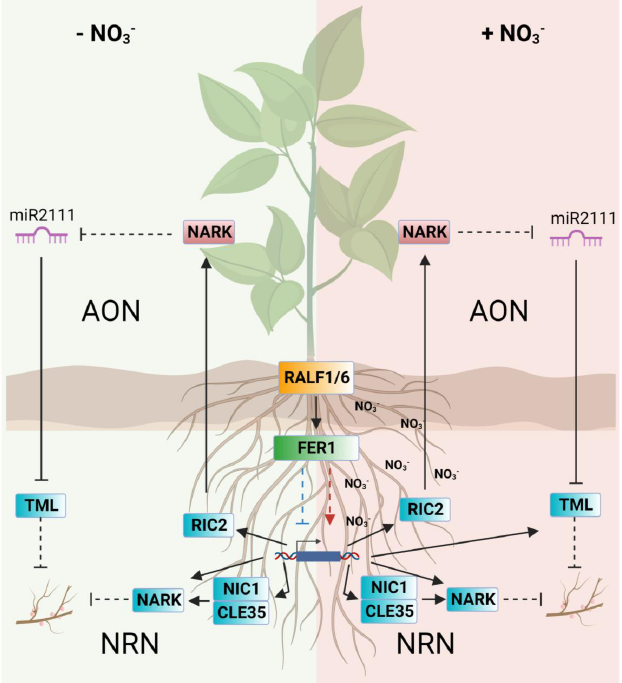
Figure 8. Proposed model for the regulation of the number of nodules in common bean by the PvRALF1/6-PvFER1 complex as a function of nitrate levels. In the absence of nitrate (left panel), RALF1 and RALF6 (orange box), and probably other RALFs, are perceived by FER1 (green box) and mediate the downregulation of the AON and NRN pathways, inducing the formation of more nod- ules. When nitrate is present (right panel), the RALF peptides are recognized by FER1 and mediate the upregulation of the AON and NRN pathways, leading to an inhibition of additional nodule formation. Solid lines indicate direct and dotted lines indicates indirect interaction. The arrowheads represent activation, and line endings indicate a repression. NO 2 − , nitrate; RALF1/6, RAPID ALKA- LINIZATION FACTOR 1/6; FER1, FERONIA 1; CLE35, CLAVATA3/ENDOSPERM-SURROUND- ING REGION (CLE) 35; NIC1, NITRATE-INDUCED CLE 1; NARK, NODULE AUTOREGULA- TION RECEPTOR KINASE; RIC2, RHIZOBIA-INDUCED CLE 2; TML, TOO MUCH LOVE; AON, autoregulation of nodulation; NRN, nitrate-mediated regulation of nodulation.